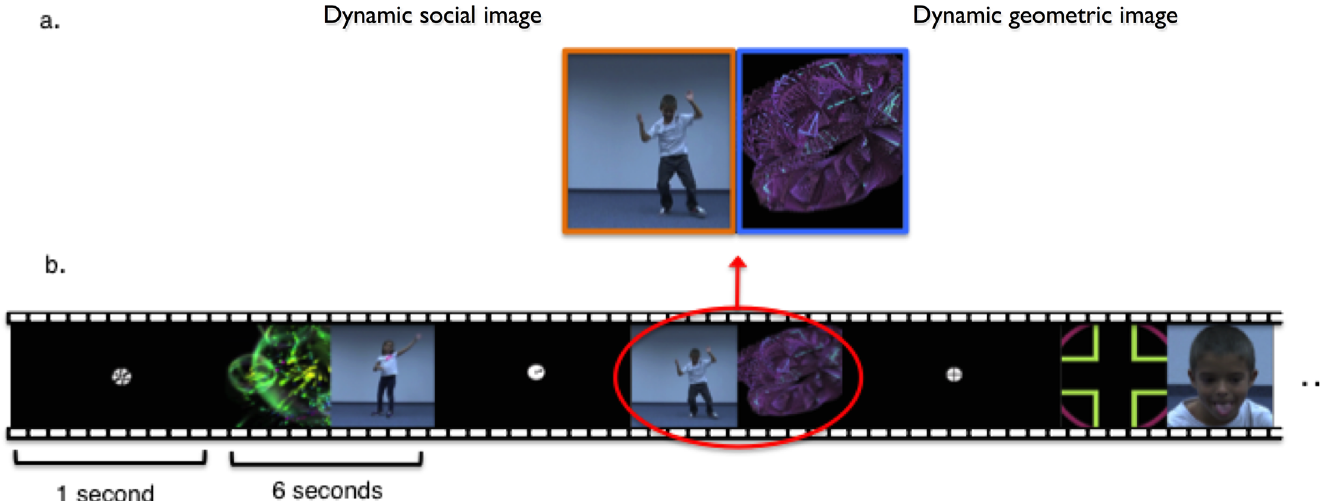
Fig 1. a. Screenshot representingthe DSI-TASK task (adaptedfrom Franchini et al., 2016, [23]). Areas Of Interest (AOI) correspond to the left (DSI, in orange)and the right (DGI, in blue) halves of the screen. b. The DSI-TASK task is composed of ten discrete segments. DSI and DGI stimuli are randomly assignedto the left or right sides of the screen for each segment. Between each segment, we used a turning wheelto bring participants’ visual attentionto the center of the screen.